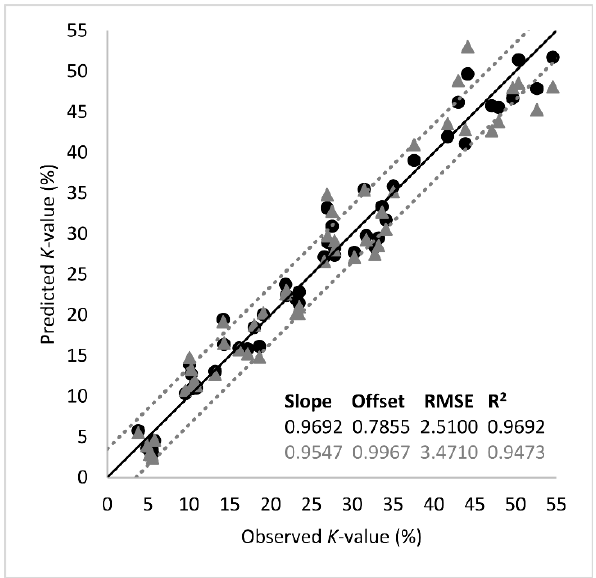
Figure 5. Comparison between the observed and predicted K -values (%) by the partial least squares regression (PLS-R) model based on important metabolites listed in Table 1. The shape of symbols denotes the calibration (-●-) and the validation (- ▲ -) set (black line: the ideal y = x line; dotted lines: ± 3.5% K -value).